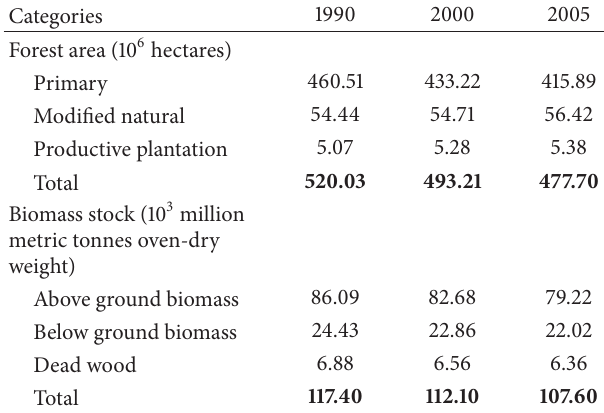
Table 1: The forest area and biomass stock in Brazil from 1990 to 2005. This table shows a dramatic reduction in both forest quantity and quality. The data is obtained from the website of Food and Agriculture Organization of the United Nations, global forest resources assessment, 2005 available online at: http://www.fao.org/forestry/country/32185/en/bra/ and http://www .fao.org/forestry/country/32183/en/bra/.